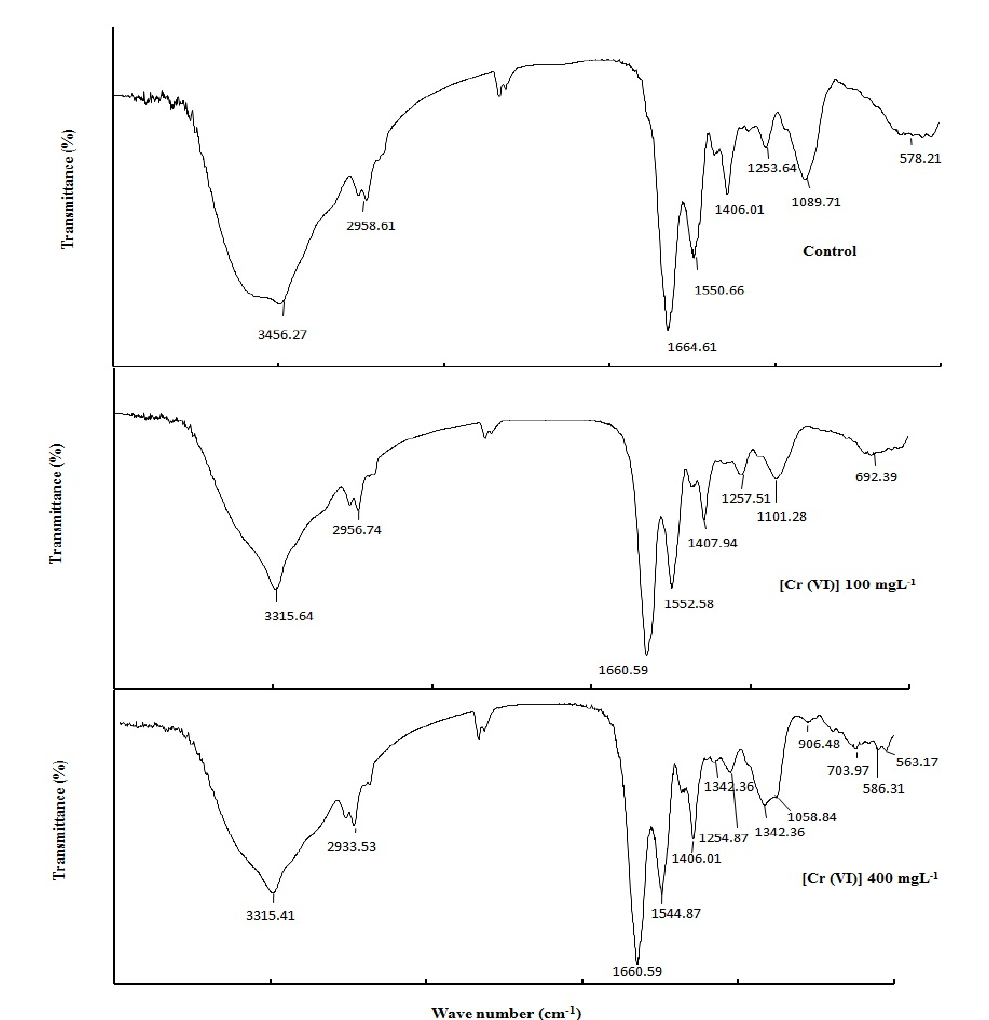
Fig. 7. FTIR spectra of the Alcaligenes sp. CKCr-6A strain with and without Cr(VI) in LB medium after 24